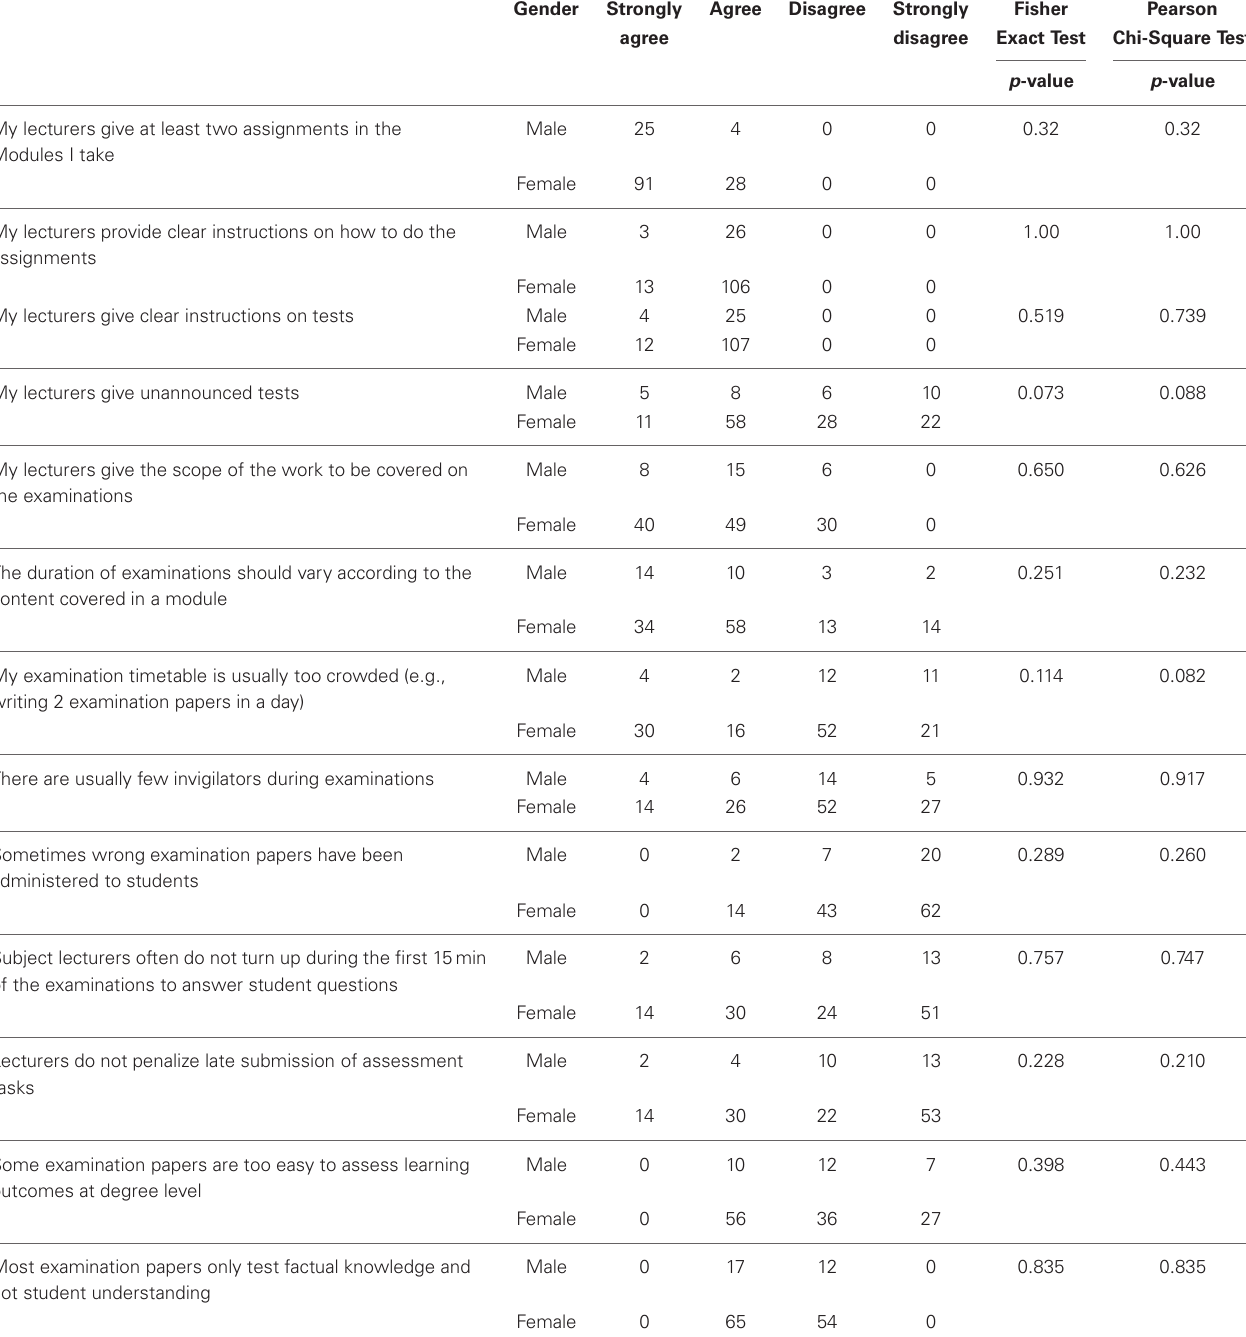
Table 2 | Factors associated with the students’ views and perceptions on practices and